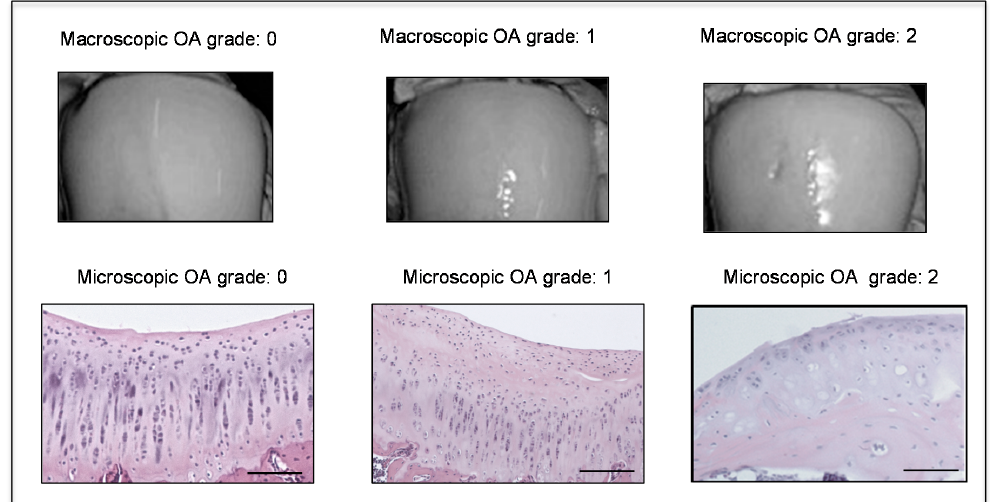
Figure 2. Macroscopic and microscopic articular cartilage degeneration between OA grade 0 to OA grade 2 according to macroscopic Kraus’ modified Mankin score and microscopic histopathology OARSI system, Magnifications ×20, scale bars 100 µm.